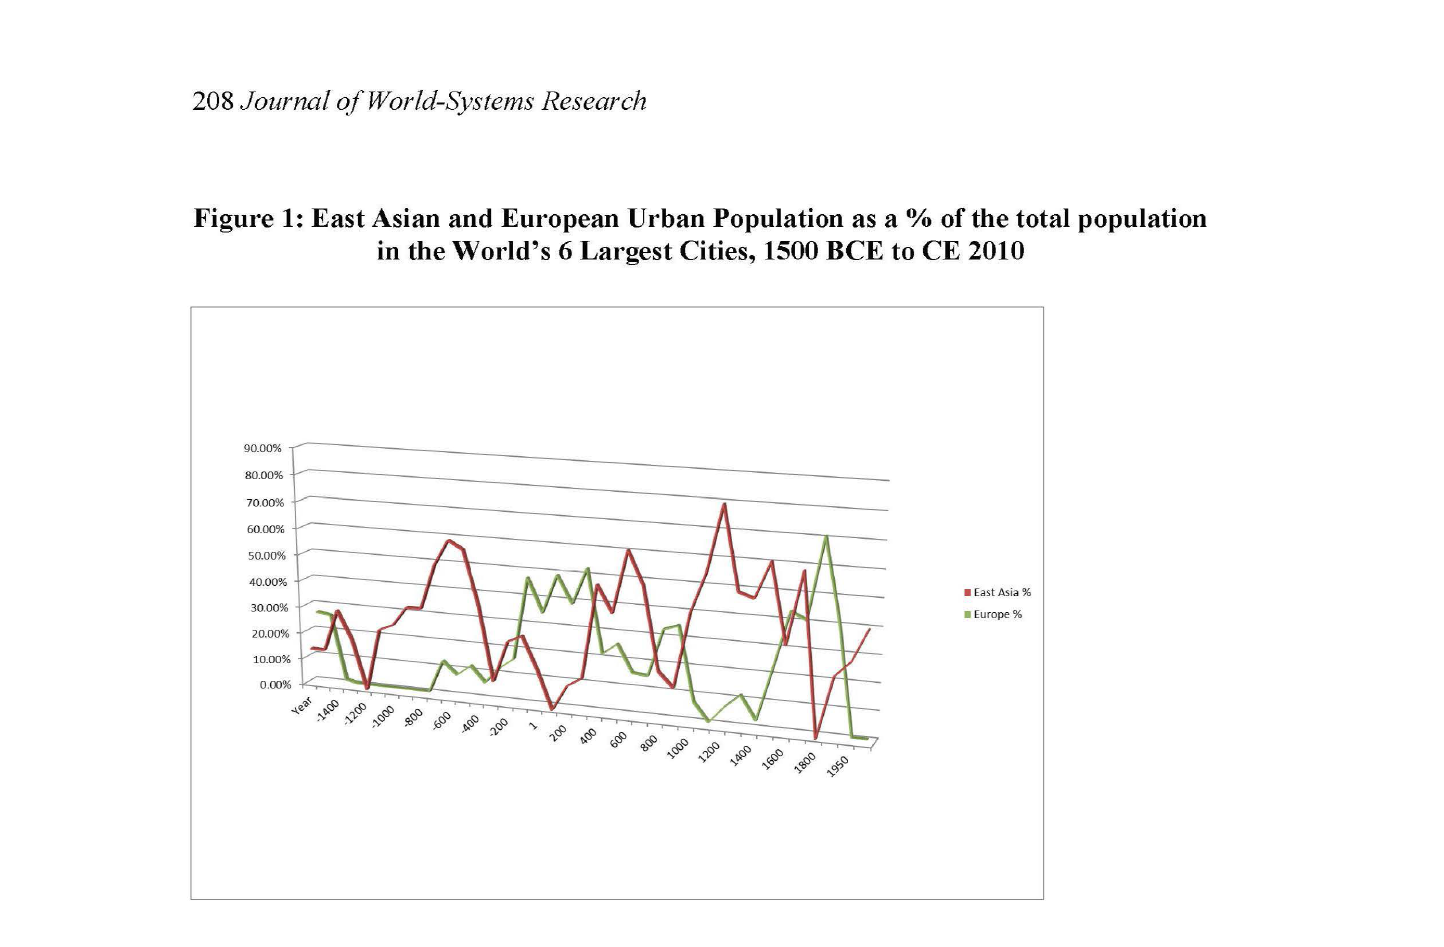
Figure 1: East Asian and European Urban Population as a% of the total population in the World's 6 Largest Cities, 1500 BCE to CE